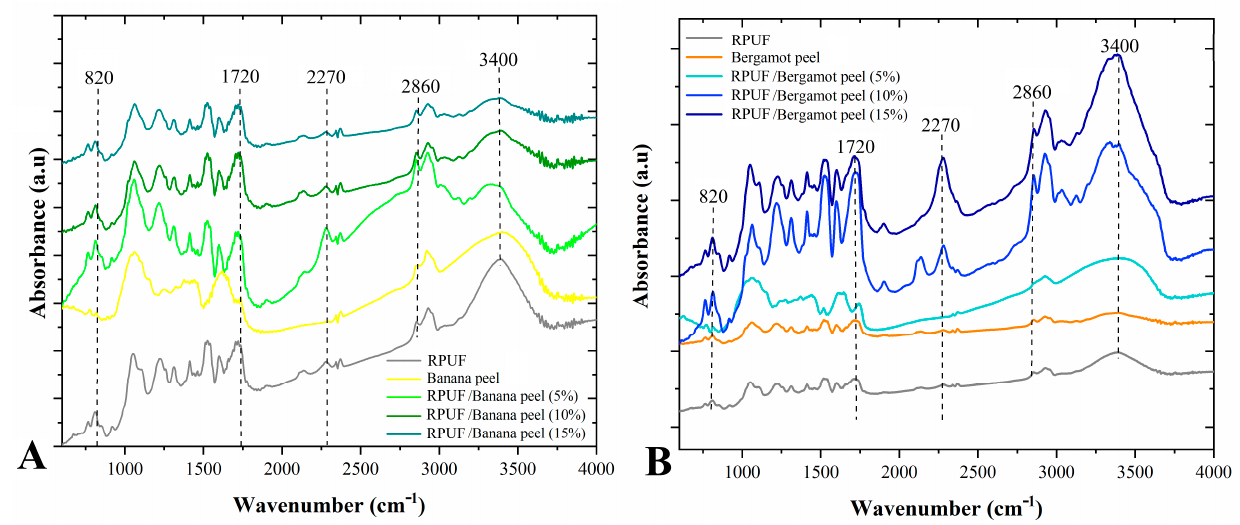
Figure 3. FTIR of the studied RPUF with Banana peels ( A ) and Bergamot peels ( B ). Where: RPUF is the neat rigid polyurethane foam, and filler type and filler content are the numbers after the bars and between parentheses, respectively.